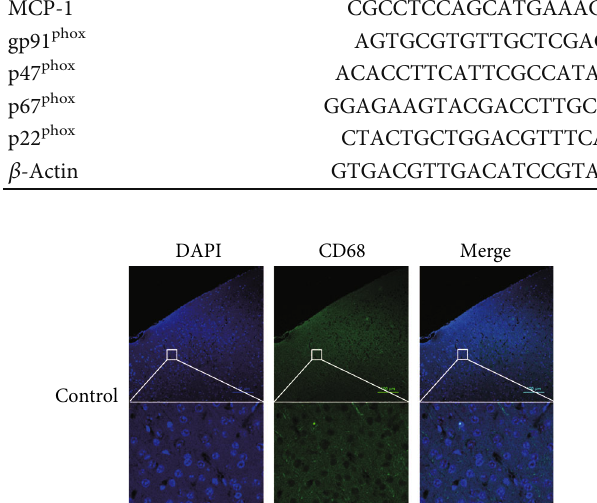
Figure 5(b)), 3 : 7 ± 1 : 2 -fold ( p < 0 : 001 , Figure 5(e)), and 3 : 8 ± 1 : 5 -fold ( p < 0 : 001 , Figure 5(f)), respectively. Western gp91 phox , p47 phox , p67 phox , and p22 phox increased 1 : 4 ± 0 : 4 ( p < 0 : 05 , Figure 5(c)), 1 : 8 ± 0 : 3 ( p < 0 : 05 , Figure 5(d)), 1 : 5 ± 0 : 3 ( p < 0 : 05 , Figure 5(g)), and 1 : 6 ± 0 : 2 times ( p < 0 : 01 , Figure 5(h)), respectively.